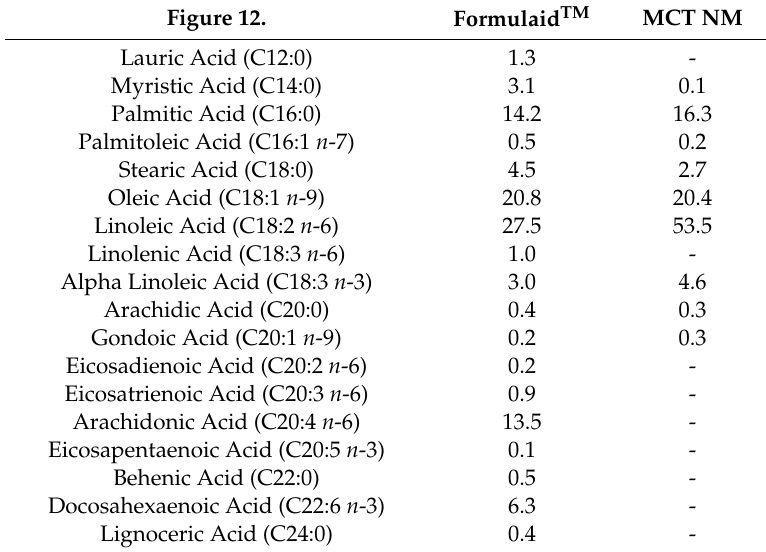
Table 1. Fatty-acid profile used for diet supplementation in the infant cohort. MCT—medium- chain triglycerides. Figure 12. Formulaid